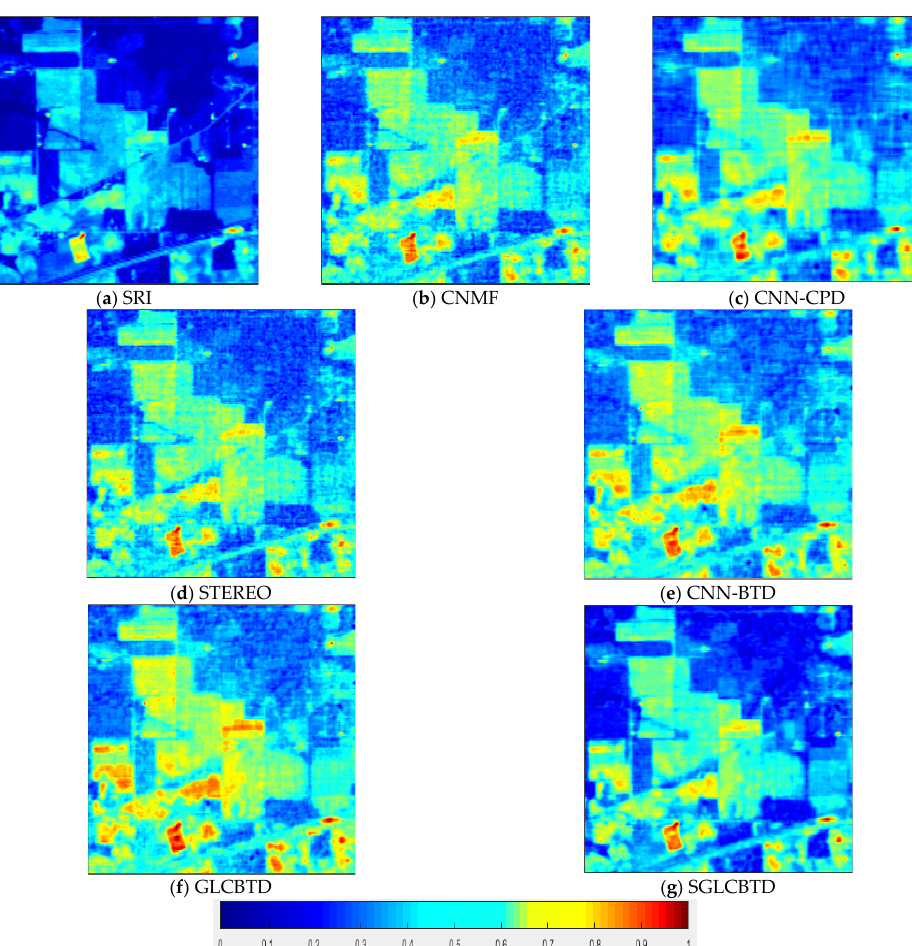
Figure 4. Comparisons of fusion results of the 10-th band on the Indian Pines dataset.